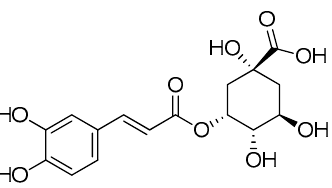
Figure 1. Molecular formula of chlorogenic acid (CGA).